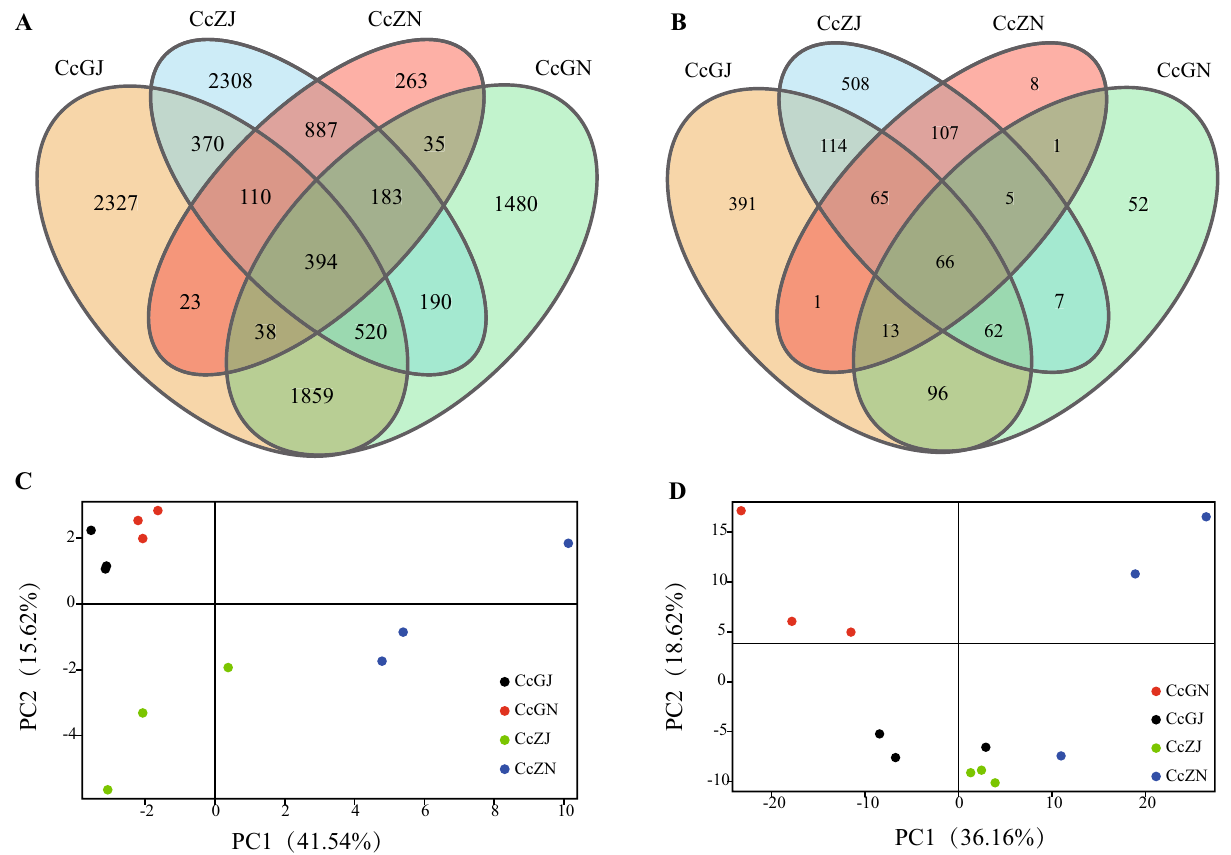
Figure 1. OTU variance analysis of microbes in the rhizosphere and endosphere of healthy and diseased Cc . ( A ) Venn diagram of bacteria; ( B ) Venn diagram of fungi; ( C ) PCA of the bacterial community; ( D ) PCA of the fungal